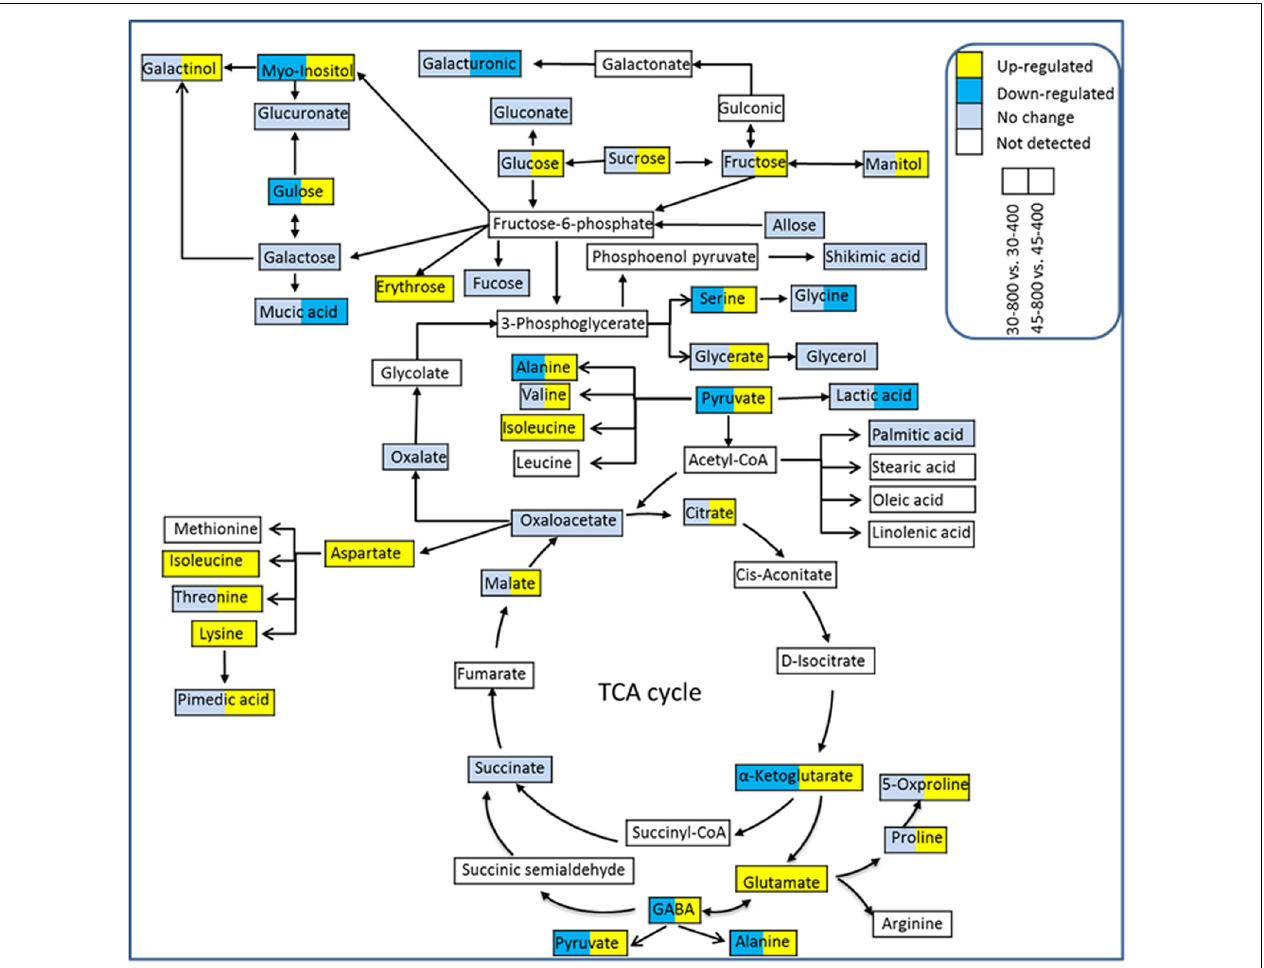
FIGURE 8 | The metabolic pathways associated with differentially expressed metabolites. The treatments symbols are 30 and 45 for normal temperature control and heat stress and 400 and 800 for ambient CO 2 and elevated CO 2 concentrations, respectively.